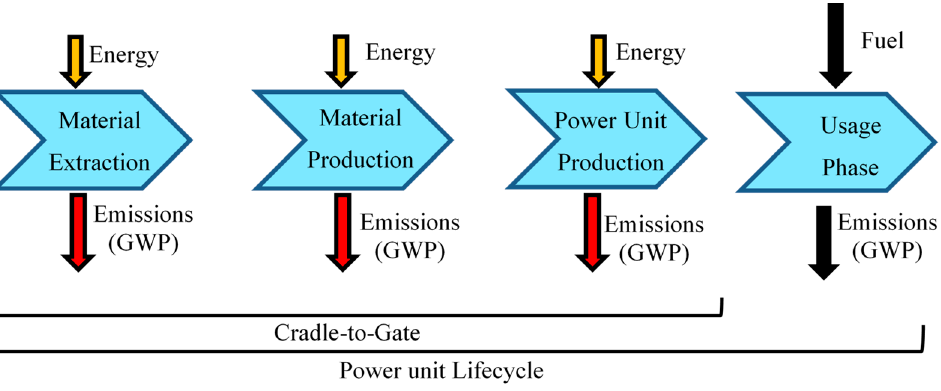
Figure 2. Simplified Overview of Methodology.